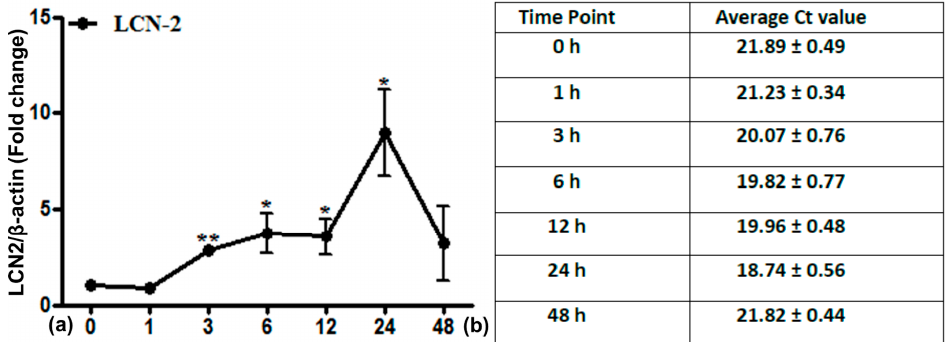
Figure 1. Fold change of mRNA expression of Lipocalin2 (LCN2) in irradiated lung tissue at time points from 1 to 48 h. Data are given relative to normal sham irradiated control rats ( a ). The results were normalized to the housekeeping gene β -actin, experimental errors are shown as ±SEM (* p ≤ 0.05, ** p ≤ 0.005, n = 3). Ct values are depicted in ( b ).